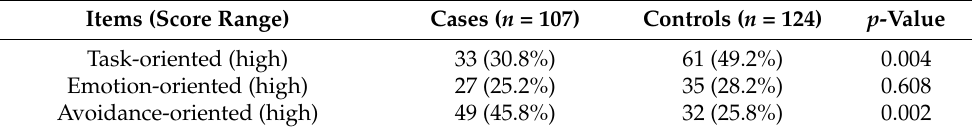
Table 3. Comparison of CISS survey results between cases and controls.